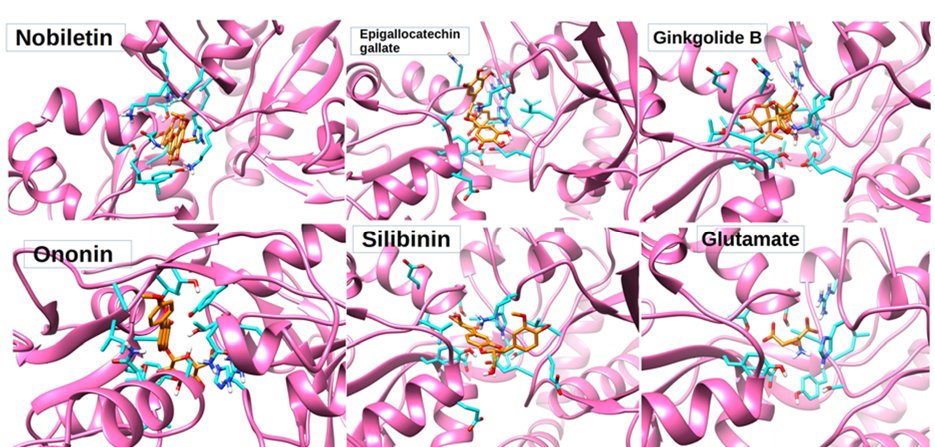
Figure 4. Three-dimensional poses of nobiletin, ginkgolide B, silibinin, ononin, and epigallocatechin gallate docked with NMDA receptor through rigid docking parameters and displaying amino acids within <5 angstrom distance in orange